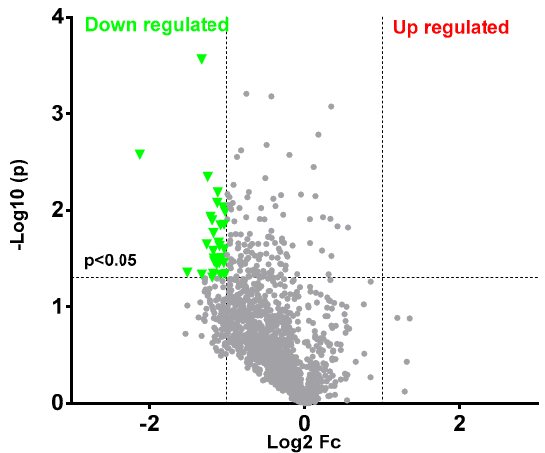
Figure 4. Protein and phosphorylation altered after coelonin treatment. From a total of 1318 differentially phosphorylated proteins, 32 were selected as significantly downregulated by coelonin using a volcano plot analysis. Table 1. The phosphorylation of 32 proteins were significantly downregulated by coelonin treatment ( p < 0.05).